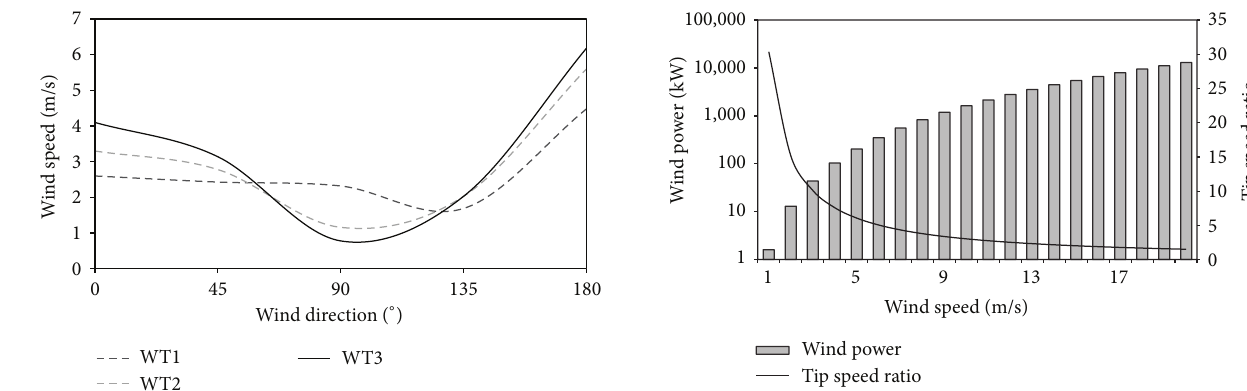
Figure 14: Analytical relationship between wind power and tip speed ratio at increasing wind